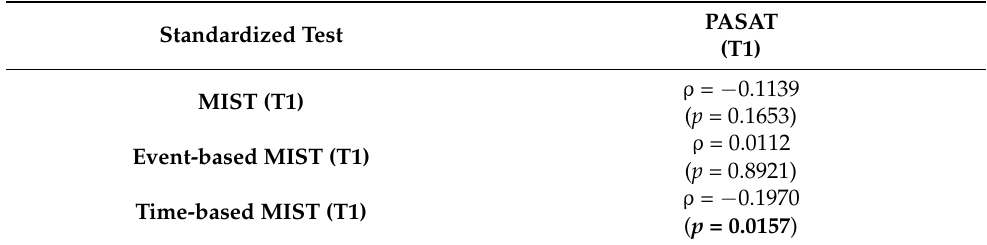
Table 4. Spearman’s correlation coefficients ( ρ ) and their significance levels ( p ) are reported between the MIST total score, the event-based, and time-based tasks scores and the PASAT score.